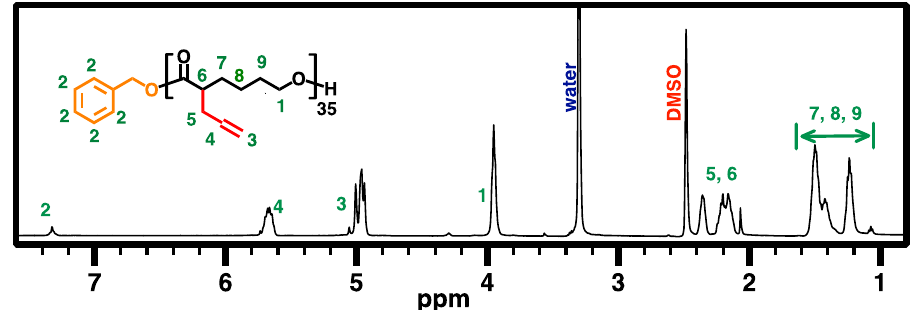
Figure 5. 500 MHz 1 H NMR spectrum of APCL ( 4 ) in DMSO-d 6 .